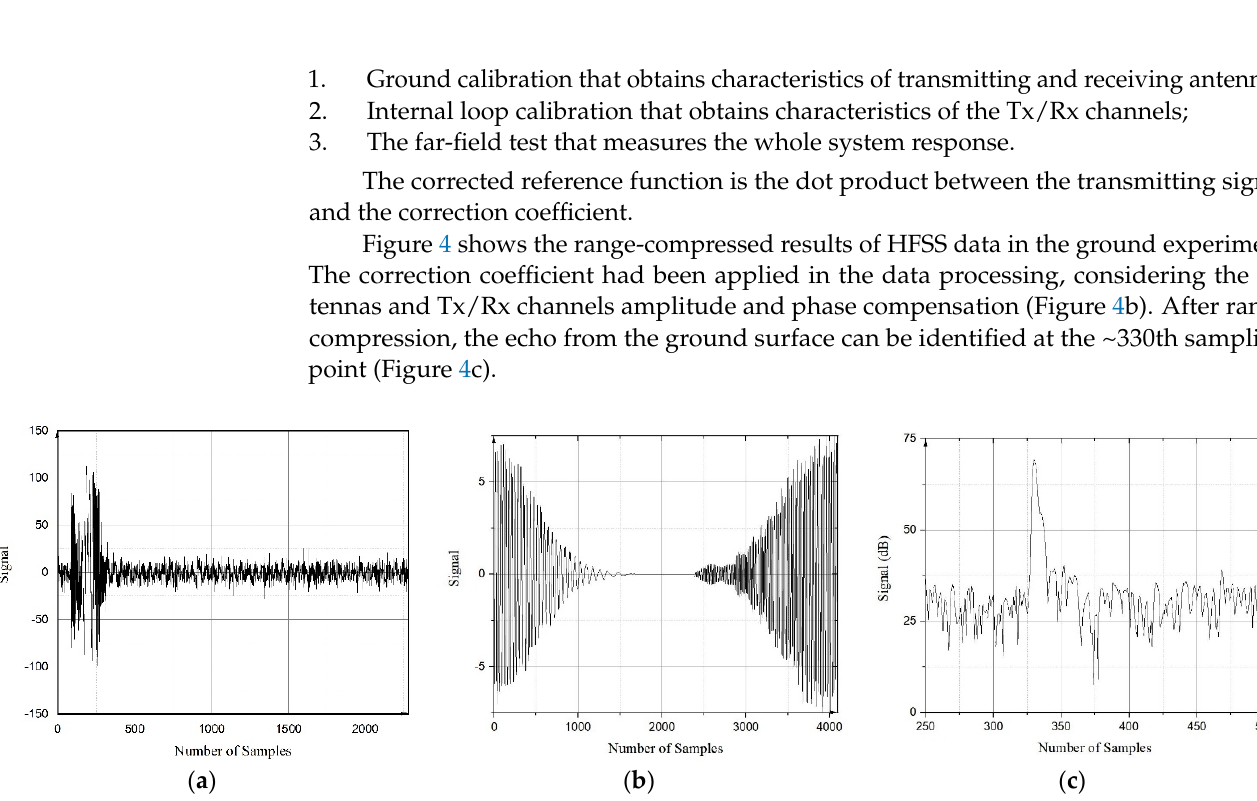
Figure 4. ( a ) Real part of a column of HFSS raw data received in the ground experiment, length of data is 2280 sampling points; ( b ) Real part of correction coefficient for the ground experimental transmitting signal, the length is 4096 sampling points; ( c ) Part of the range-compressed result of ( a ), where the surface echo can be identified at the ~330th sampling point.